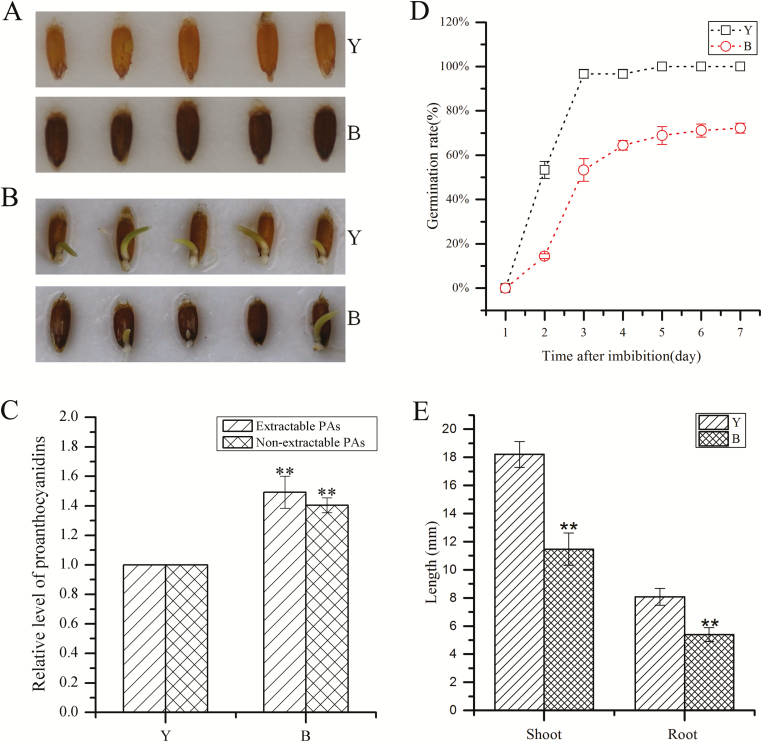
Seed morphology and germination assay of two sheepgrass germplasms. (A) Morphology of sheepgrass cultivar seeds with a yellow seed coat (Y, upper panel) and seeds with a brown seed coat (B, lower panel). (B) Germination of sheepgrass seeds 4 d after imbibition. Both seeds with a yellow seed coat (Y, upper panel) and seeds with a brown seed coat (B, lower panel) were germinated at 28 °C/12 h and 16°C/12 h under dark conditions. (C) Relative proanthocyanin content of sheepgrass germplasm with a yellow seed coat (Y) and cultivars with a brown seed coat (B). Data indicate the mean ±SD of three biological replicates (n=3, **P<0.01). (D) Germination rate of sheepgrass germplasms with a yellow seed coat (Y) and seeds with a brown seed coat (B). Data indicate the mean ±SD of three biological replicates. (E) Shoot and root length of two sheepgrass germplasms on the sixth day after imbibition. Data indicate the mean ±SD of 30 biological replicates (n=30, **P<0.01).